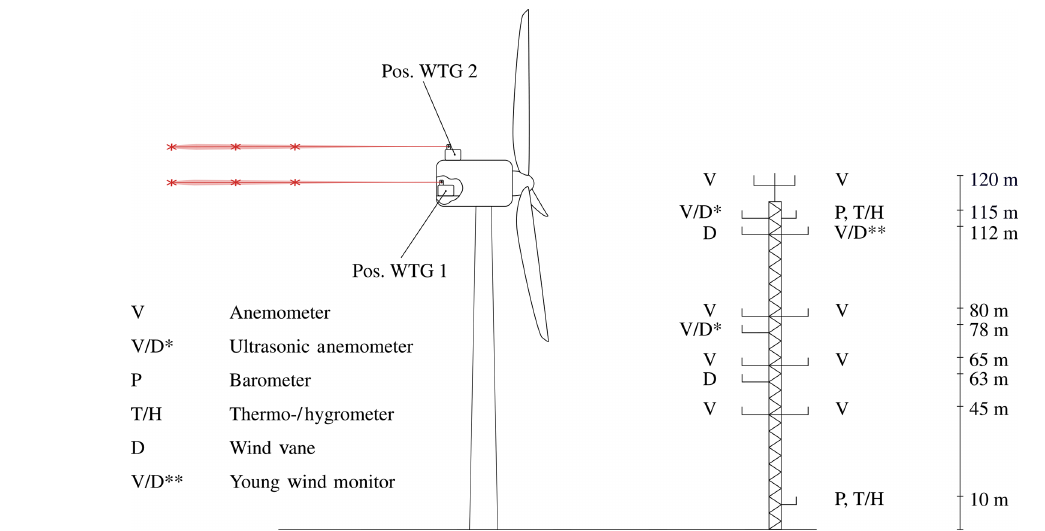
Figure 2. Met mast measurement equipment and lidar positions.